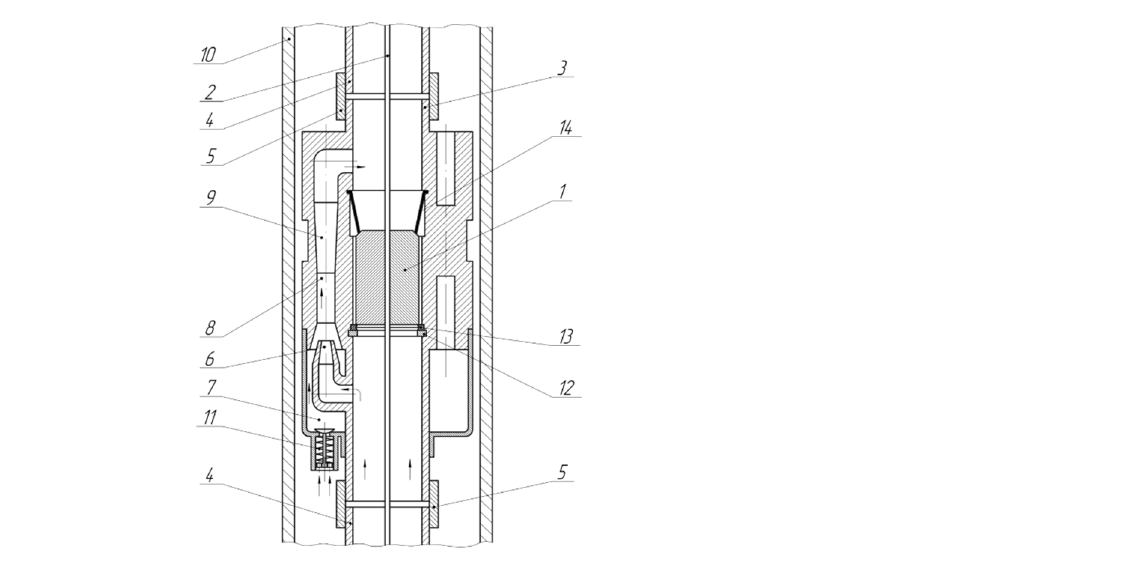
Figure 2. Construction scheme of the downhole oil-gas jet pump [85]: 1—separator; 2—rod; 3—jet pump’s body; 4—tubing; 5—collar; 6—working nozzle; 7—receiving chamber; 8—mixing chamber; 9—diffuser; 10—casing; 11—check valve; 12—spring ring; 13—packing seal; 14—retainer.